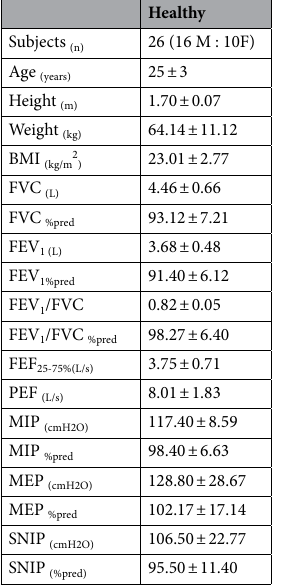
Table 1. Subjects characteristics. FVC: forced vital capacity; FEV 1 : forced expired volume in 1 s; FEF 25-75% : forced expiratory flow at 25–75% of FVC; PEF: peak expiratory flow; MIP: maximal inspiratory pressure; MEP: maximal expiratory pressure; SNIP: Sniff nasal inspiratory pressure; m: meters, kg: kilograms; L: liters; %pred: percentage of predicted; cmH 2 O: centimeters of water; M male; F: female. Values are shown as mean ±